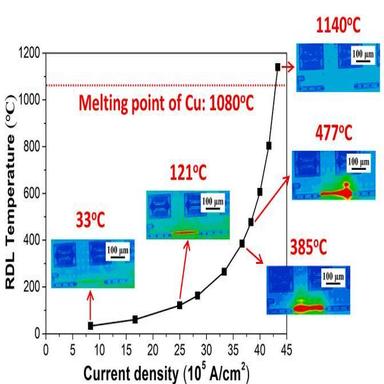
TCR temperature predictions accompanying the IR qualitative temperature distribution analysis of the Cu interconnect under the electromigration experiment for various applied current densities. (Single-column; Color online). (For interpretation of the references to color in this figure legend, the reader is referred to the Web version of this article.)